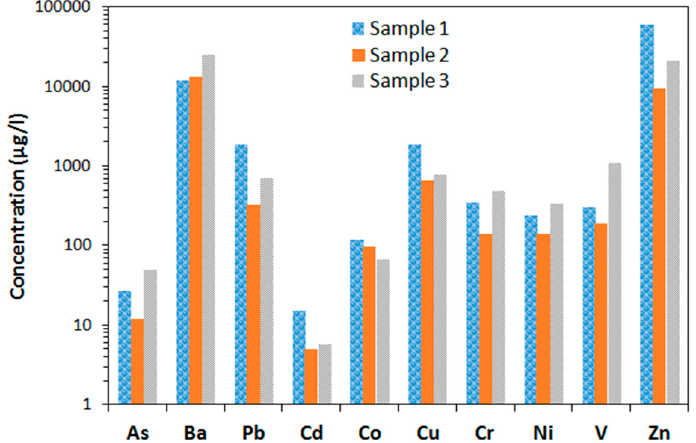
Figure 2. Concentration of metals in the collected fire extinguishing water samples from three different locations.